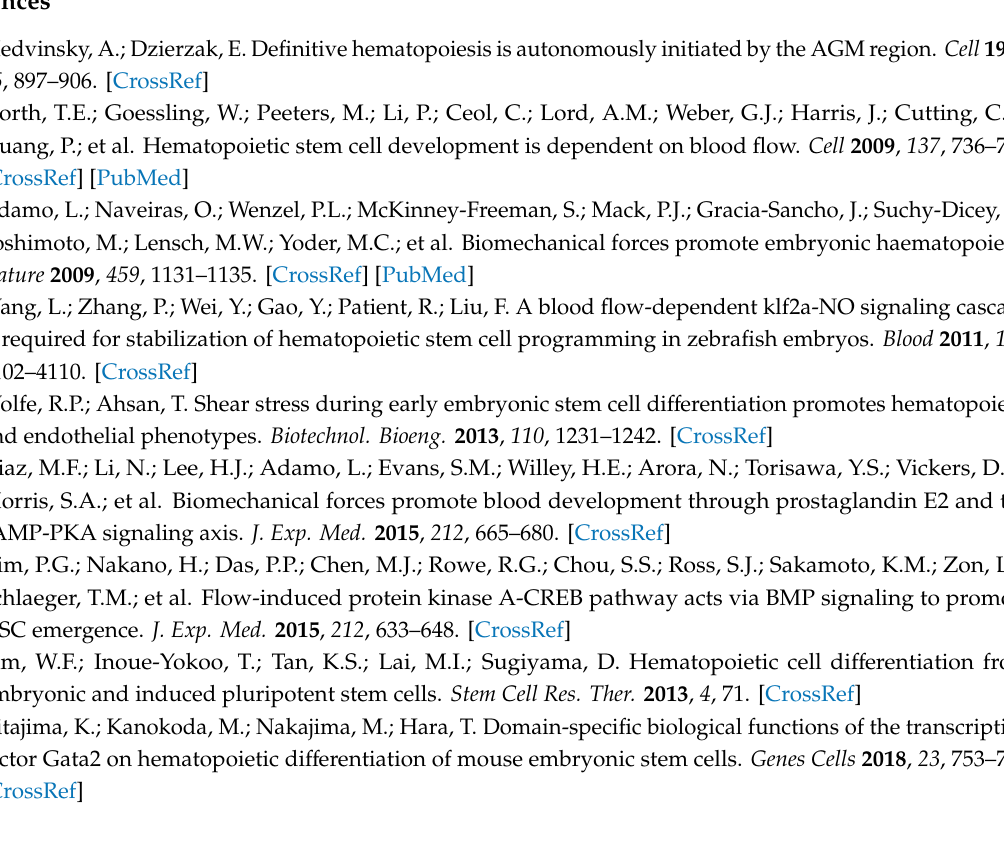
Figure S1: Phase contrast and live / dead images of the blood cells and OP9 cells, Figure S2: Observation of mCherry ESCs before and after flow culture, Figure S3: E ff ects of filtered conditioned